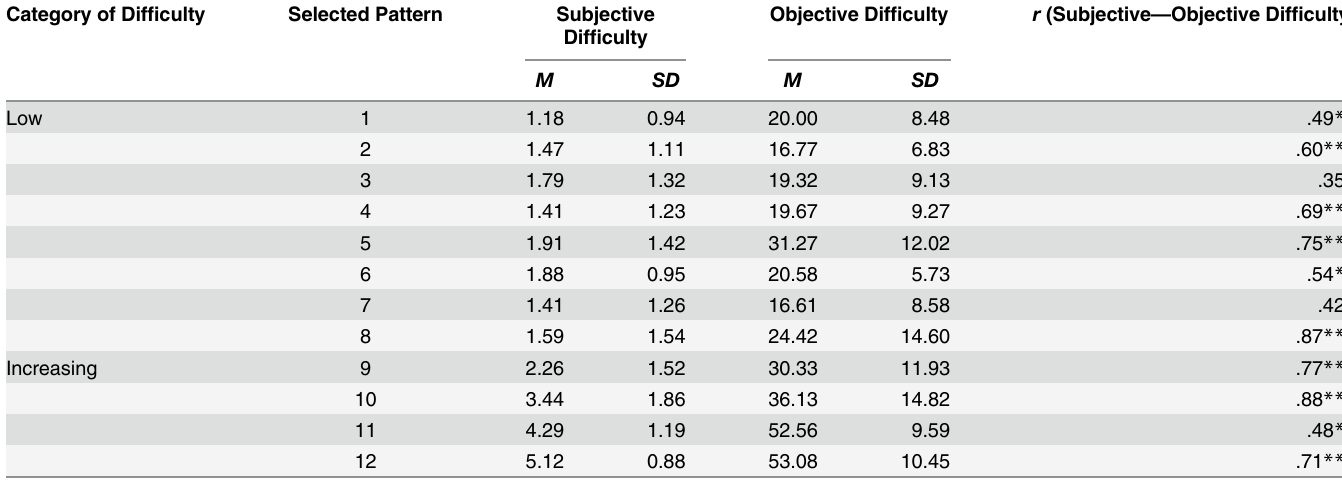
Table 1. Descriptive Statistics and Correlations Between the Subjective and Objective Difficulties of the 12 Selected Patterns. Category of Dif fi